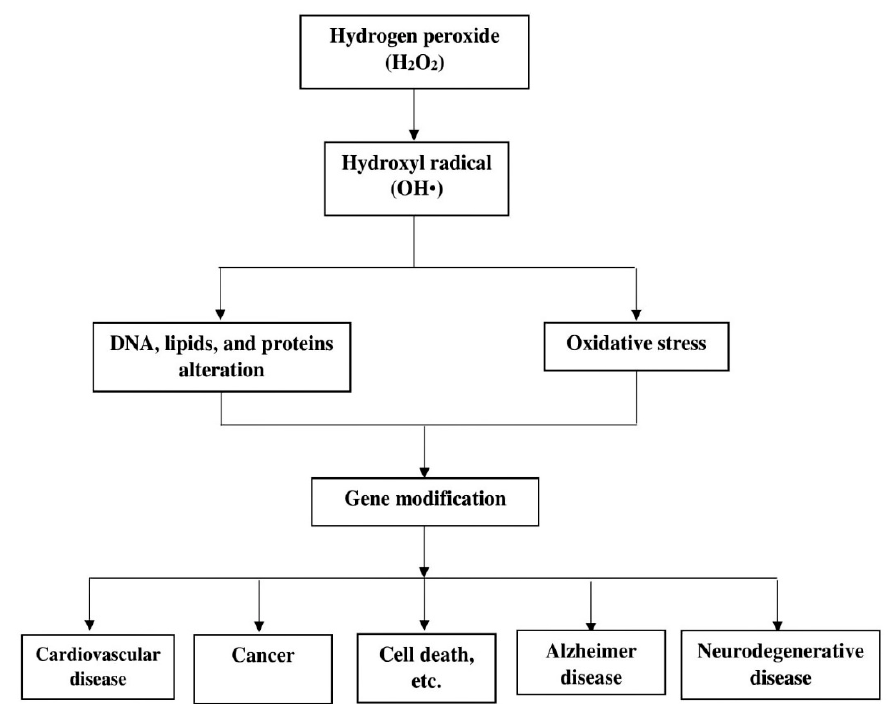
Figure 2. The role of hydrogen peroxide (H 2 O 2 ) in cell dysfunction and transformation.